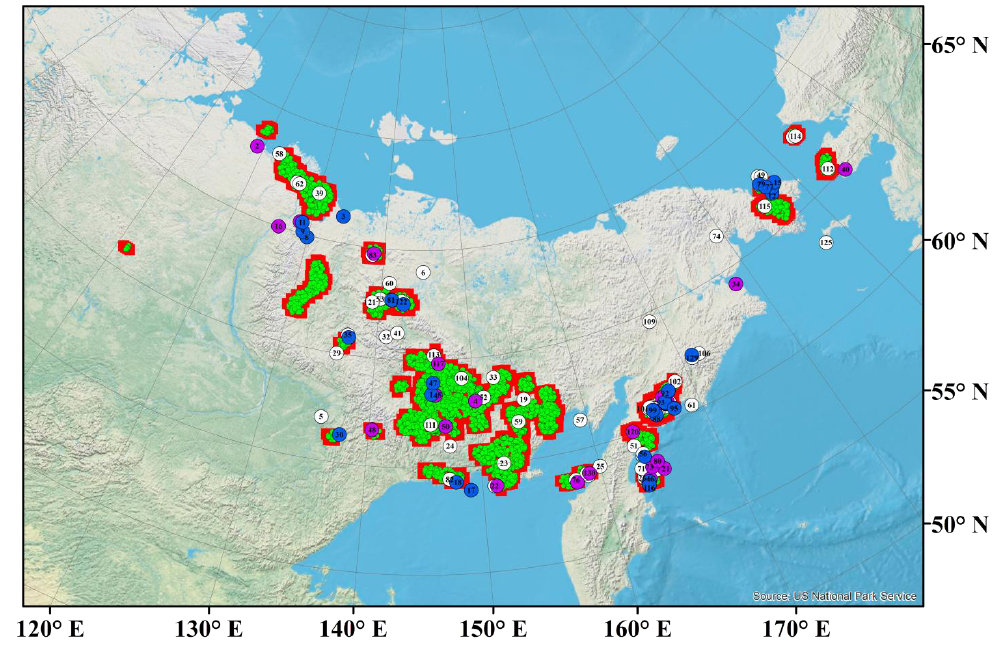
Figure 4. FCAZ zones prone to earthquakes (calculated at M R = 2.0) in the eastern sector of the Russian Arctic and earthquake epicenters with M ≥ 5.0. Designations as in Figure 3.